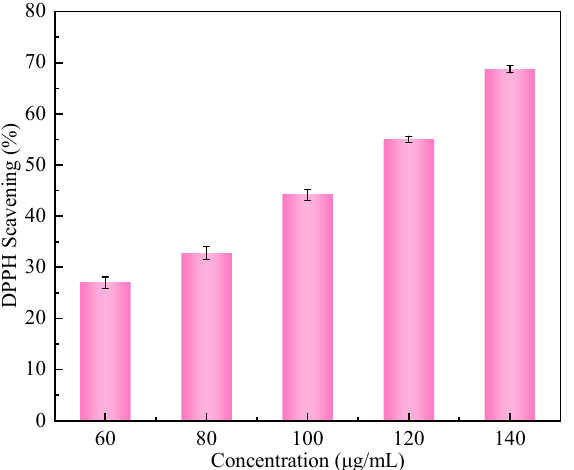
Figure 8. DPPH scavenging rate of zein/SC/CA composite NPs with different mass concentrations (60, 80, 100, 120, and 140 μ g/mL).